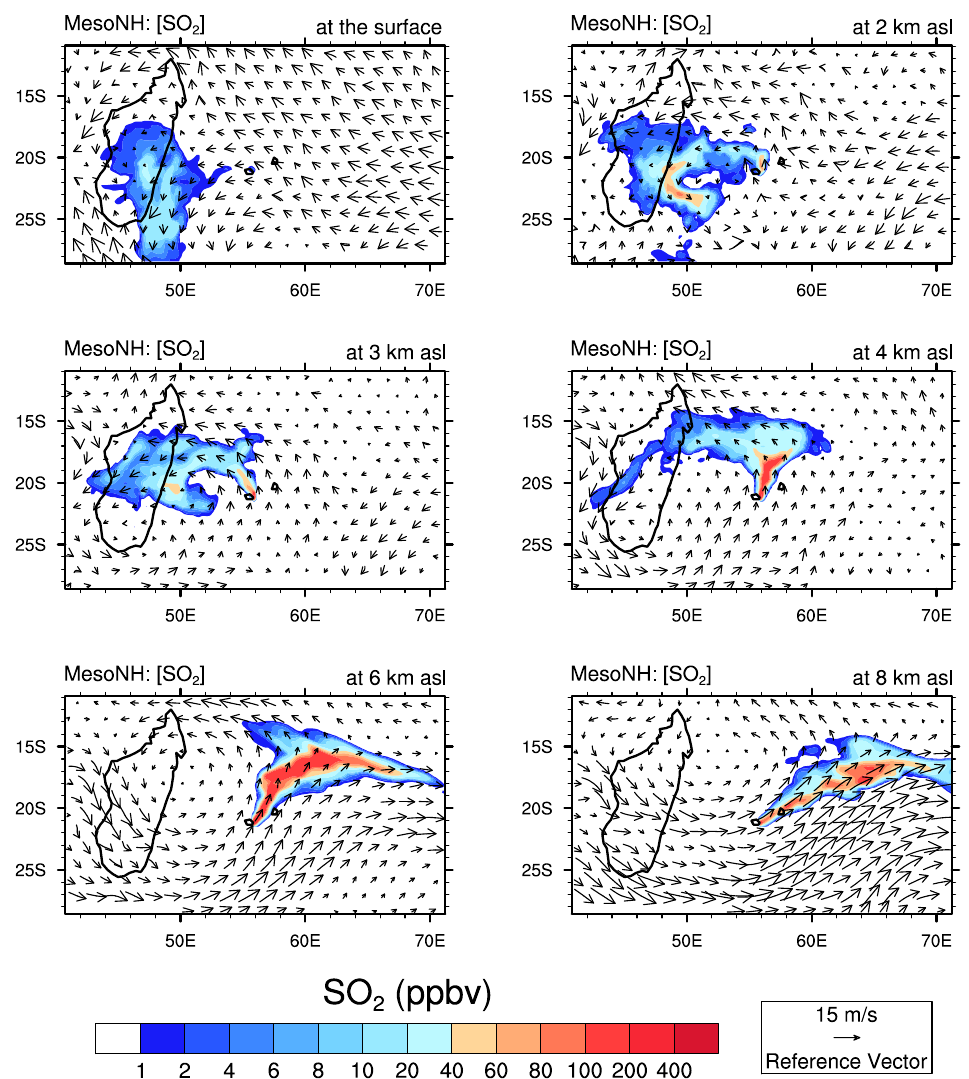
Fig. 6. Mixing ratio of SO 2 (ppbv) and horizontal wind vector (reference at the bottom right) simulated by MesonH on 7 April 2007, at different levels (surface, 2 km asl, 3 km asl, 4 km asl, 6 km asl and 8 km asl).